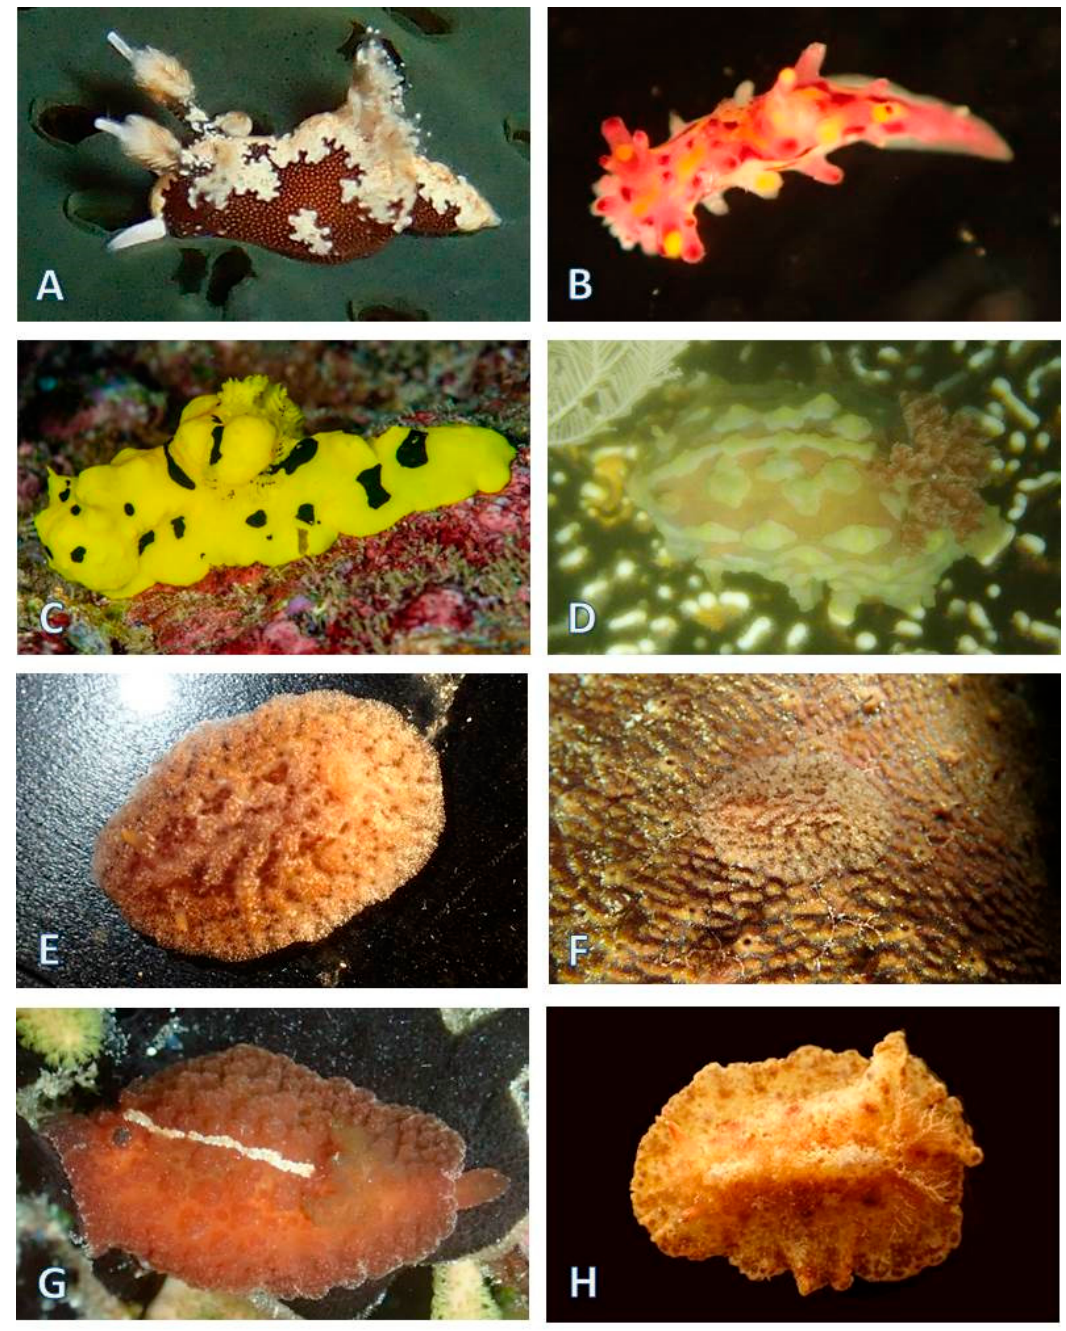
Figure 9. Nudibranchia Doridina: ( A ) Trapania safracornia*; ( B ) Aegires sp. (Aegires sp. 7 in Gosliner et al. [24]: 149), Aesp7-18Ba-1; ( C ) Notodoris minor*; ( D ) Asteronotus cespitosus*; ( E ) Asteronotus mimeticus, Asmi18Ba-2; ( F ) Asteronotus mimeticus substrate, Asmi18Ba3S; ( G ) Atagema intecta, Atin18Ba-2; ( H ) Discodoris cebuensis, Dice18Ba-1. *Specimen not collected. Aegiridae : Both acknowledged aegirid genera were present in our collections: Aegires sp. (Figure 9B), depicted in Gosliner et al. [24] as Aegires sp. 7, and the “banana sea slug” Notodoris minor (Figure 9C) (the latter only by